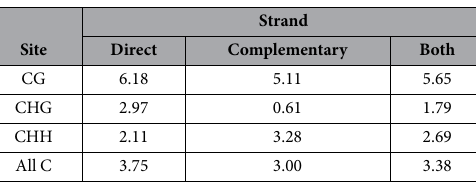
Table 1. Proportion (%) of methylated cytosines in SSUsat monomers according C site type and DNA